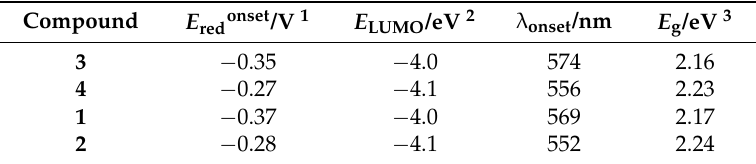
Table 1. Electronic structures of 2-cyclohexylethyl-NDTI derivatives ( 3 and 4 ).